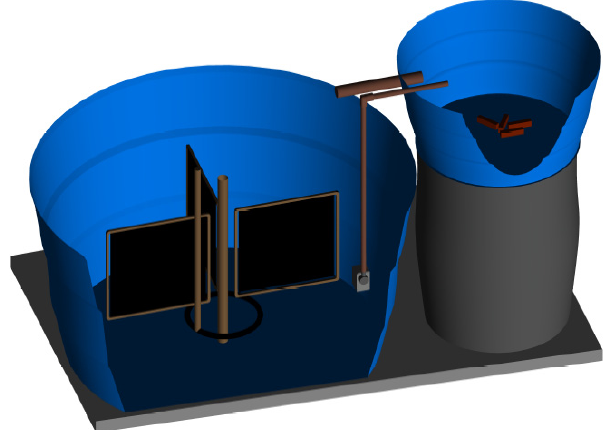
Figure 1. Schematic drawing of the experimental units used in a Pacific white shrimp ( Litopenaeus vannamei ) and Nile tilapia ( Oreochromis niloticus ) integrated culture using biofloc technology for 62 days, in which the addition or no addition of both microalgae and fish feed were evaluated in a factorial design.